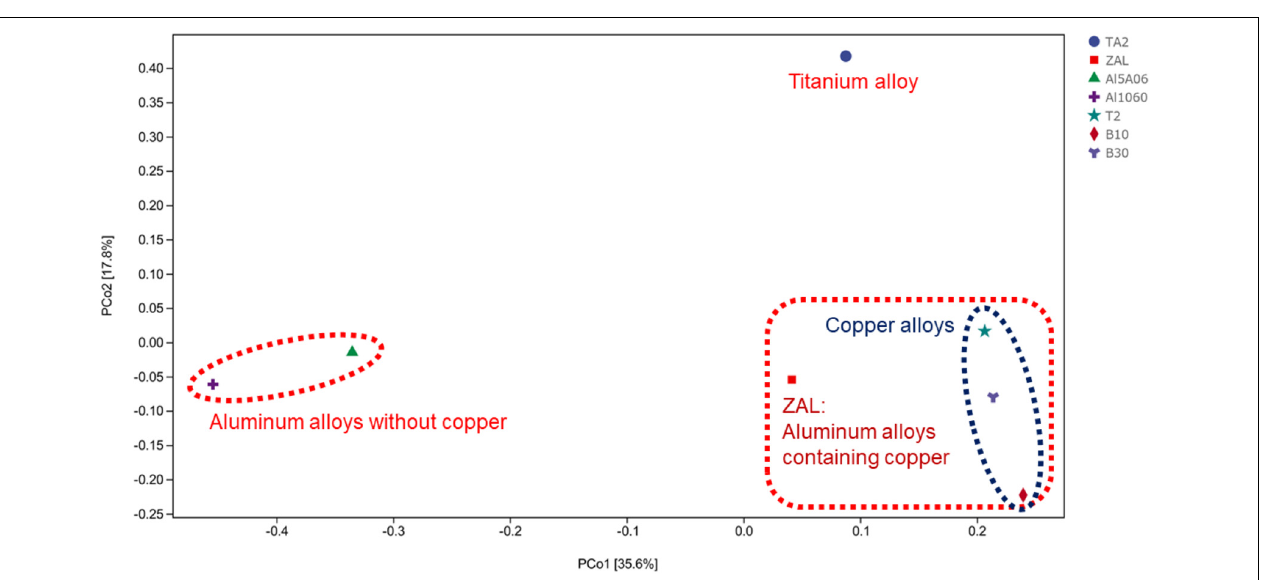
FIGURE 4 | Principal coordinate analysis plots of unweighted unifrac between seven samples in Yap Trench based on operational taxonomic units using 16S rRNA gene sequencing (TA2, ZAL, Al5A06, Al1060, T2, B10, and B30 represented the biofilms collected from the corresponding alloy surfaces. The percentages in brackets on the axes represented the proportion of sample variance data that can be explained by the corresponding